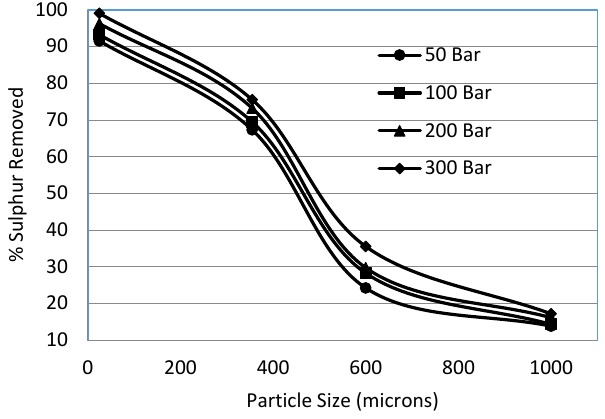
Figure 10. Effect of particle size on pyritic sulphur removal.